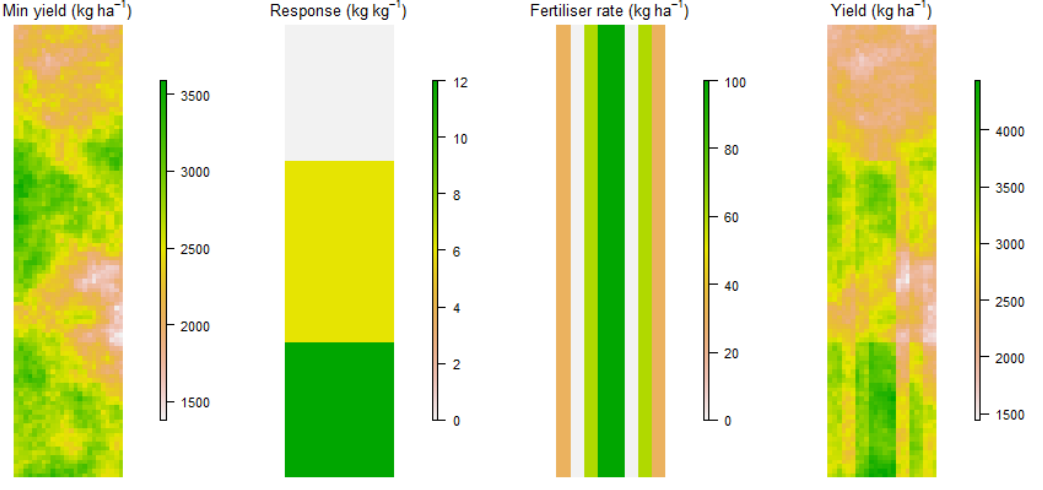
Figure 2. Simulation of local linear response by zones.